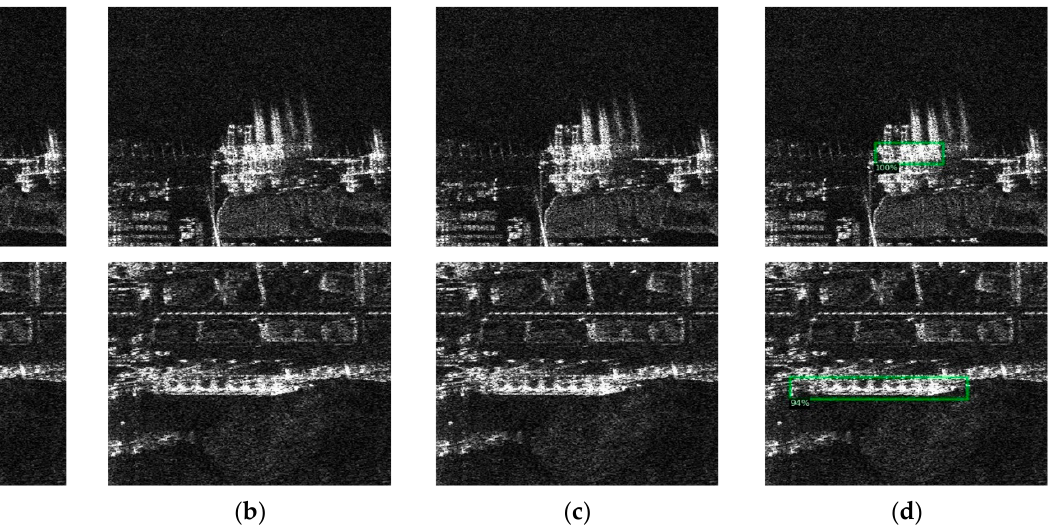
Figure 8. Visualization results of ablation experiments on the SSDD. ( a ) Ground truths. ( b ) Detection results of FCOS trained by focal loss. ( c ) Detection results of FCOS trained by GAP loss. ( d ) Detection results of FCOS with SCSA module trained by GAP loss.